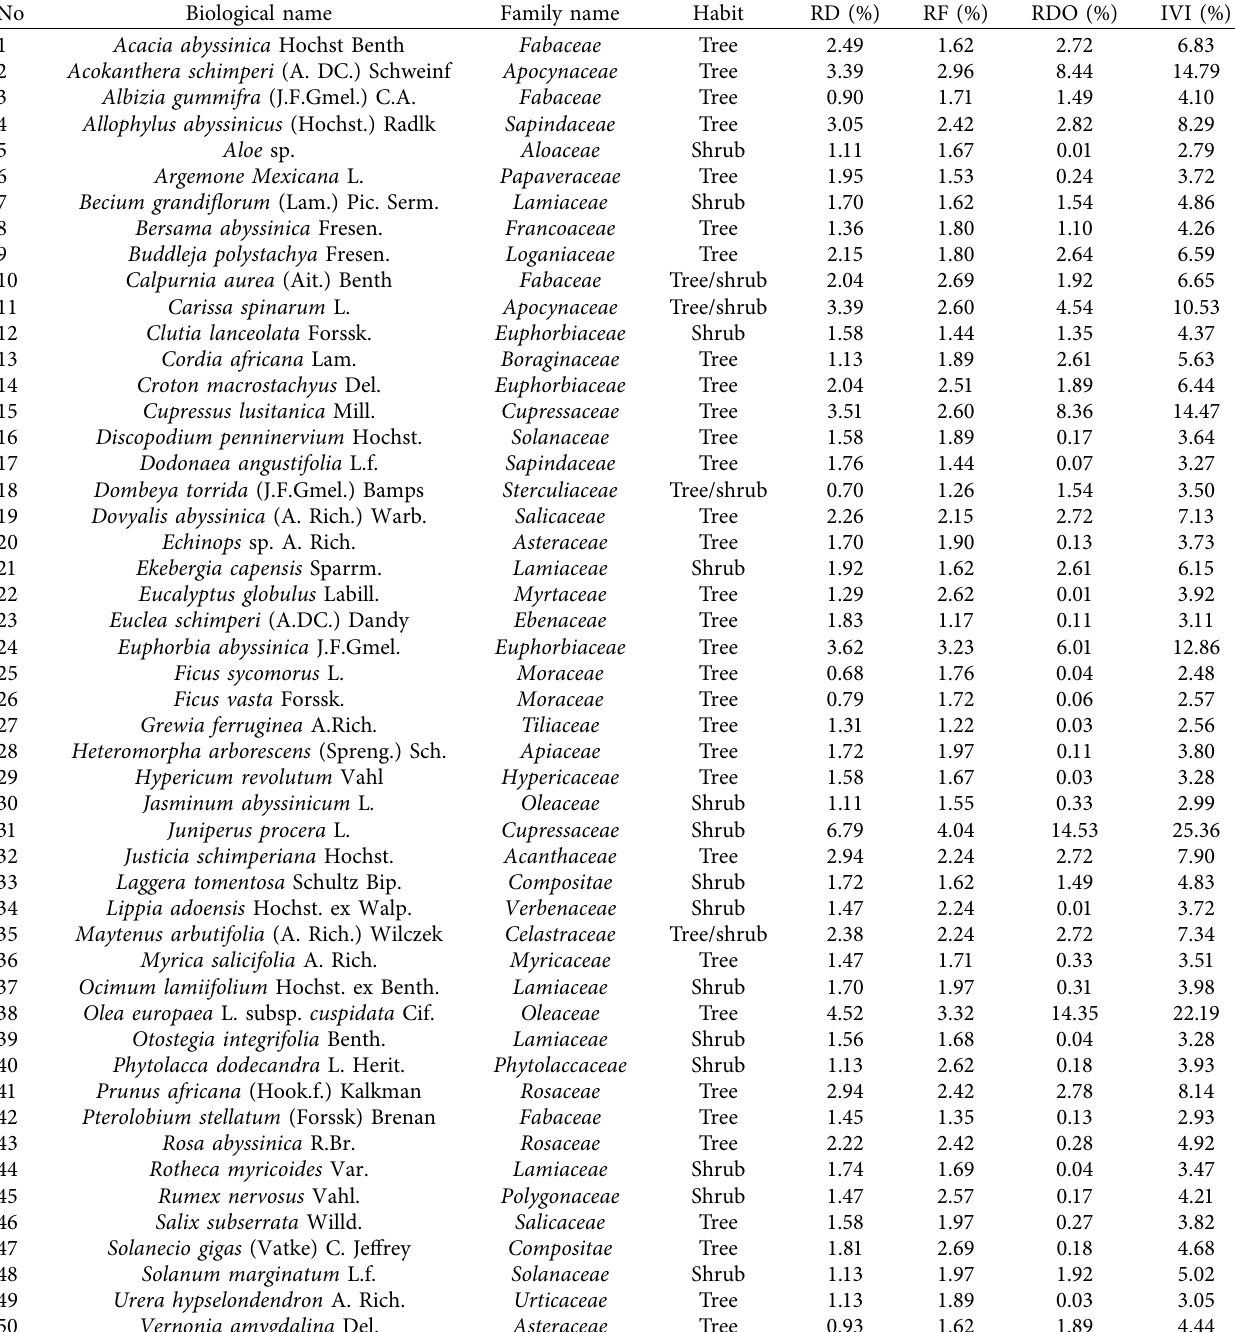
Table 1: List of woody plant species in Saleda Yohanes Church forest with their vegetation